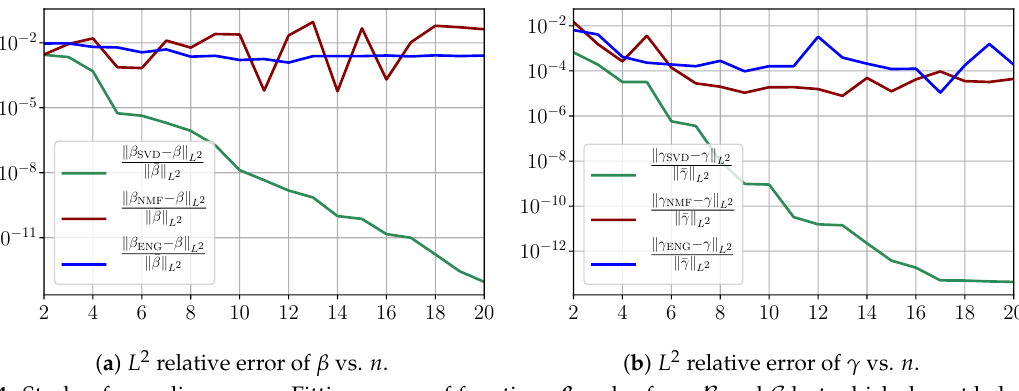
and but which do not belong to the B G